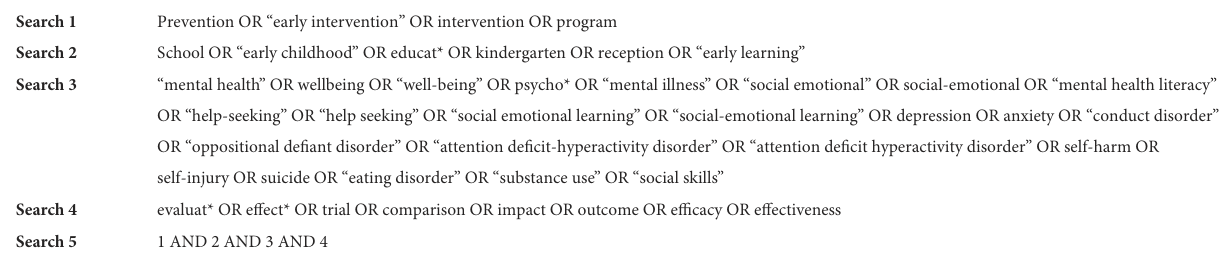
TABLE 1 Structure of search terms applied in the literature